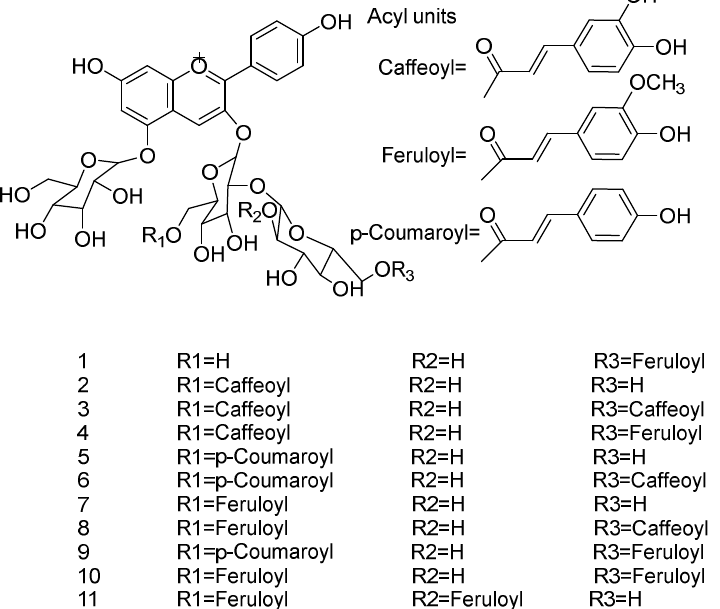
Figure 1. Structures of acylated anthocyanins from red radish extracts. [6]. Reproduced with permission from Matsufuji, J. Agric. Food Chem .; published by ACS,